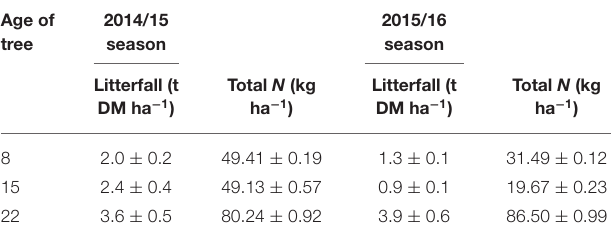
TABLE 1 | Foliar litterfall quantity and nitrogen return for three age classes of Faidherbia albida trees for two growing seasons (average ± SE; n = 3). Age of